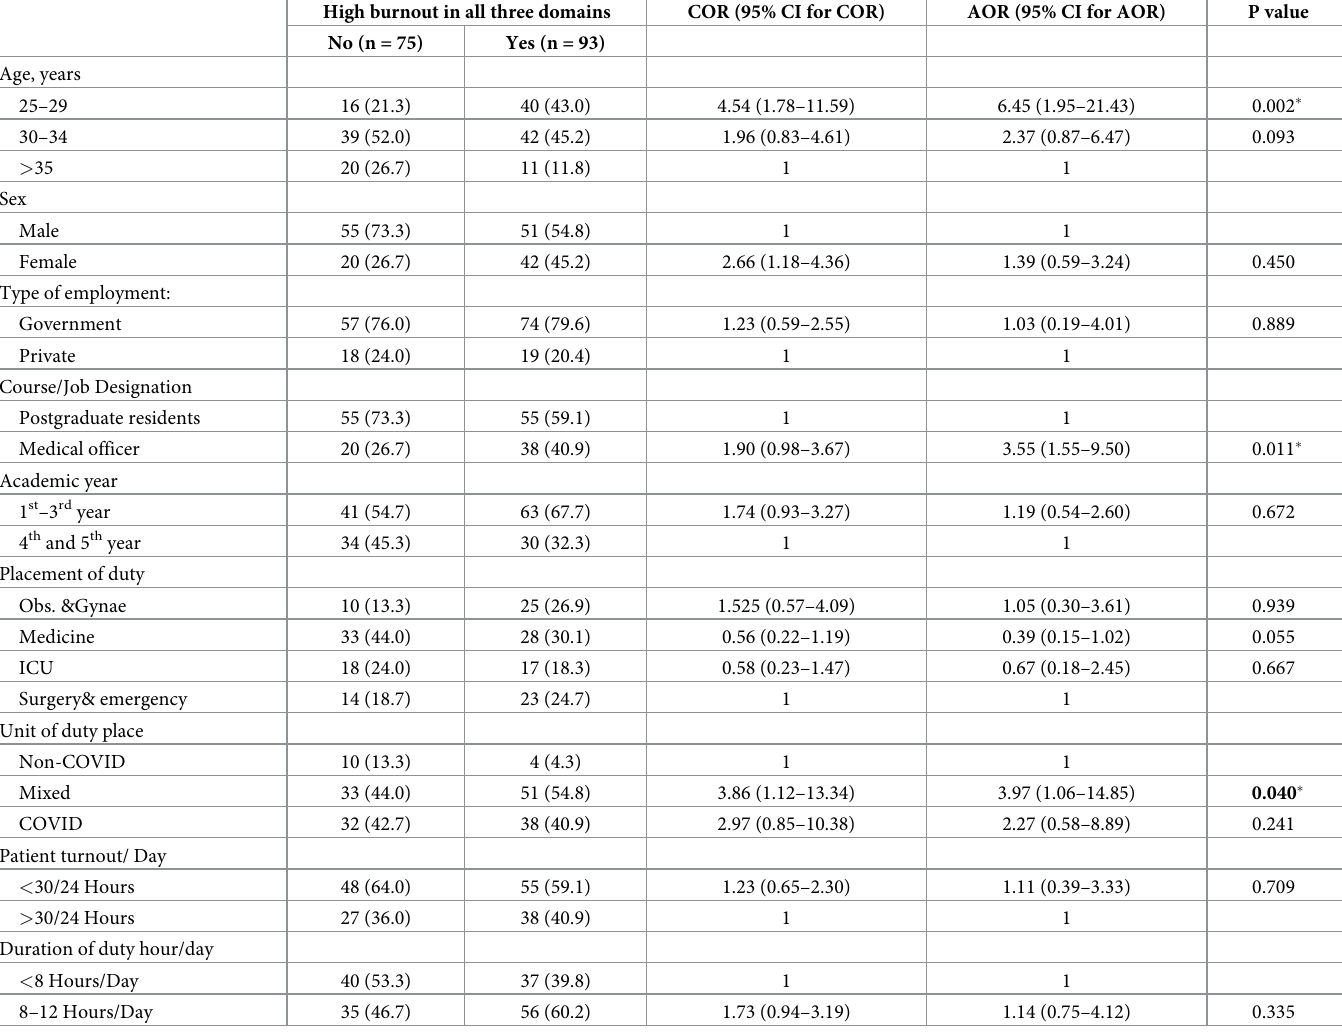
Table 5. High Burnout in all three domains and demographic and job-related characteristics (n =